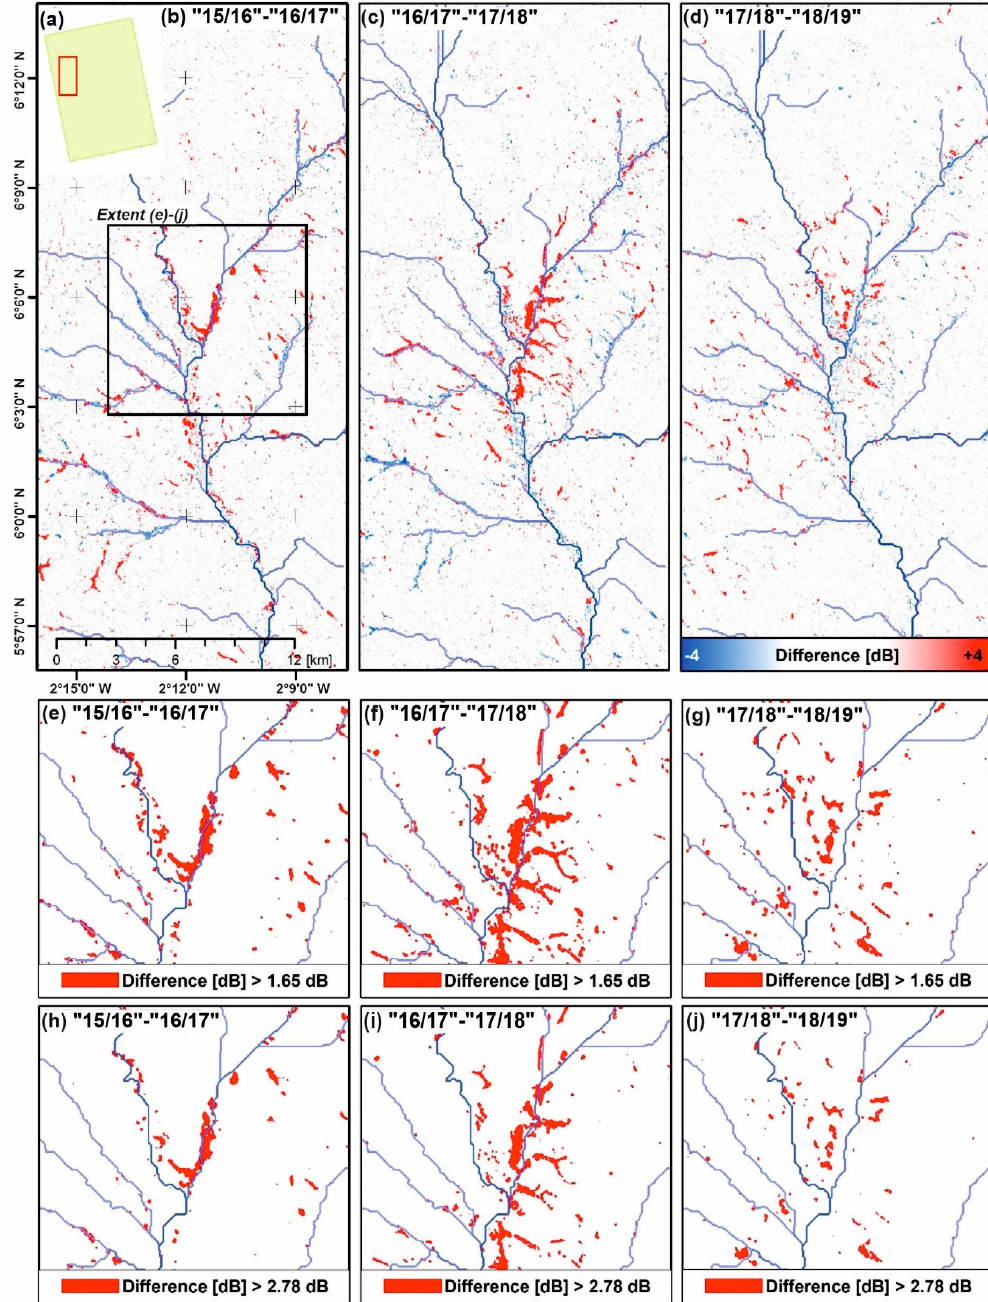
Figure 8. Classification of changes based on two different thresholds: ( a ) location of the subset within the study area, ( b ) difference in VH minimum intensities between sets “2015/2016” and “2016/2017”, ( c ) difference in VH minimum intensities between sets “2016/2017” and “2017/2018”, ( d ) difference in VH minimum intensities between sets “2017/2018” and “2018/2019”, ( e – g ) classification using a threshold of +1.65 dB identified via the histogram intersection (see Table 2) and ( h – j ) classification using a threshold of +2.78 dB identified via the Otsu Algorithm (see Table 2). Note: blue polylines show the channel network (see Section 2.2.2). A majority filter of 5 by 5 pixels was applied in the post-classification to classifications (e-j) (Section 2.4).